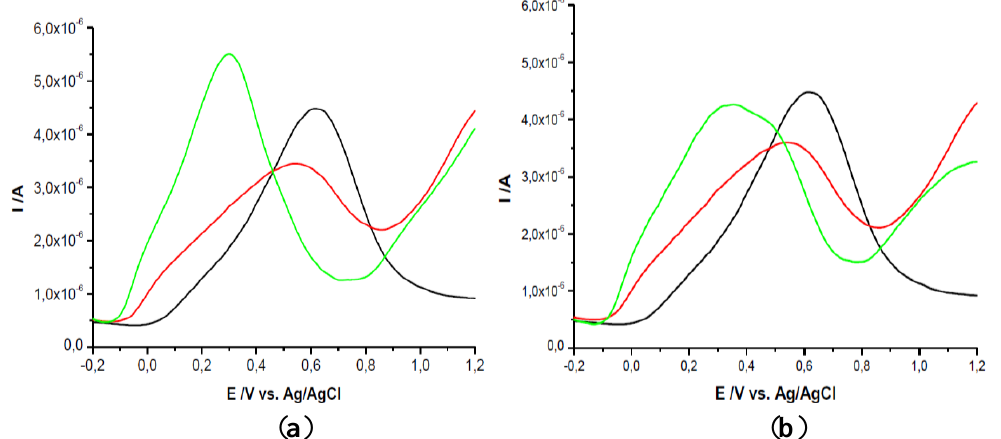
Figure 2. SWVs of AA 10 −3 M in PBS (0.1 M; pH 7.2) on bare GCE (black); GCE + PEI (red); GCE + PEI + CD (green) ( a ) PEI concentration: 5 mg/mL, β-CD concentration: 1%; ( b ) PEI concentration: 1 mg/mL, β -CD concentration: